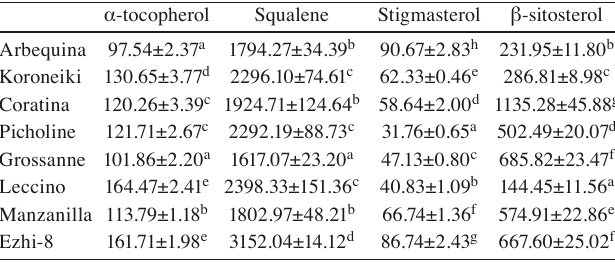
Tab. 6: α-tocopherol, squalene, stigmasterol and β-sitosterol contents of olive oil